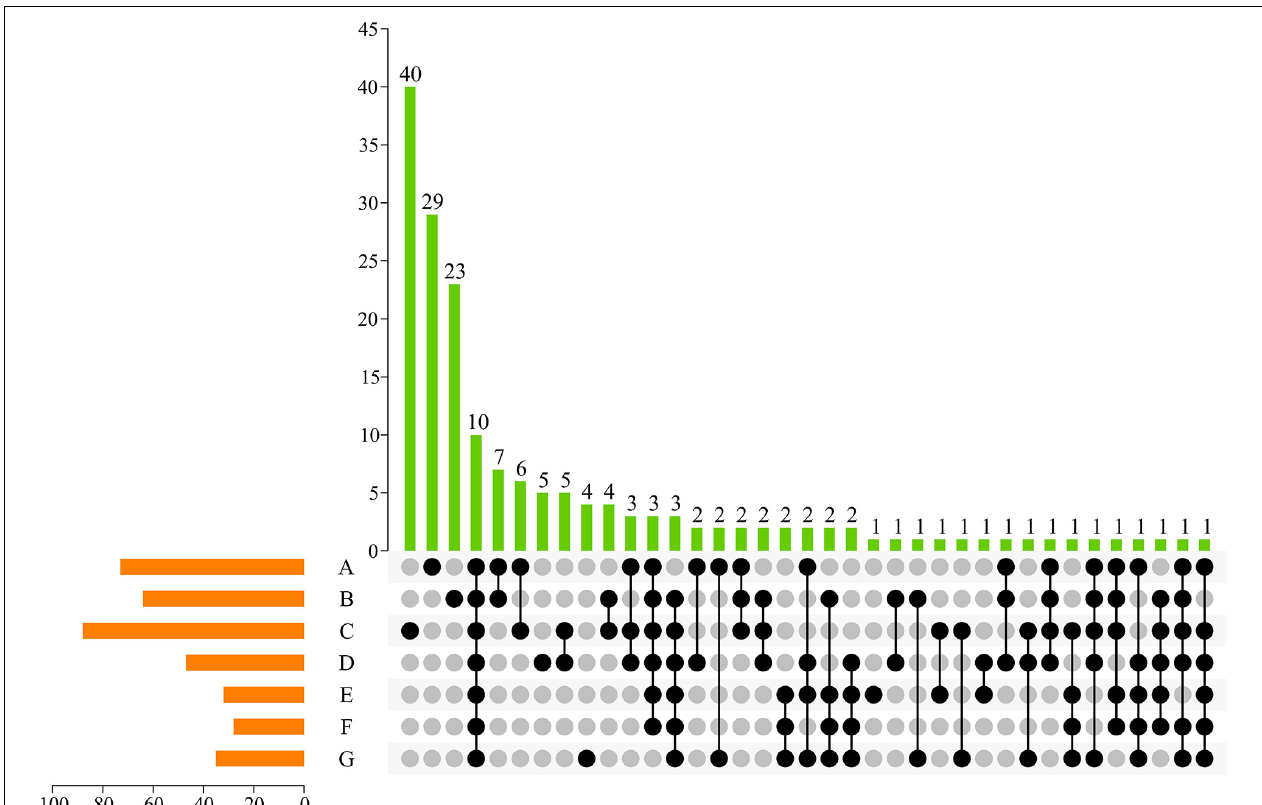
FIGURE 3 | UpSet plot of ASVs of fungal communities in different growing periods. Dark circles indicated samples with containing accessions and connecting bar indicated multiple overlapping samples.